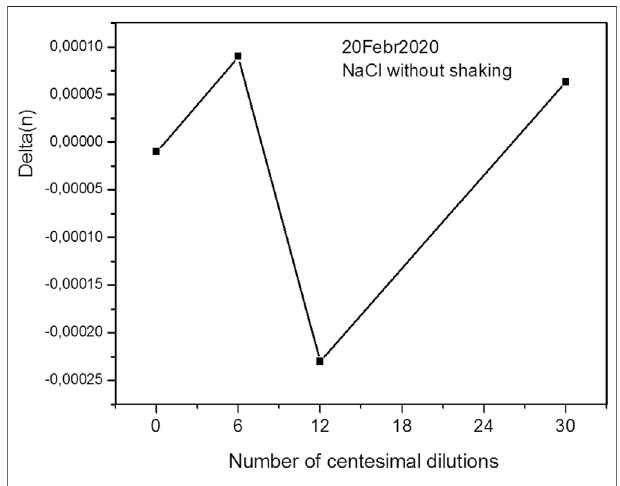
FIGURE 9 | Relative refractive index of the NaCl water dilution for different number of